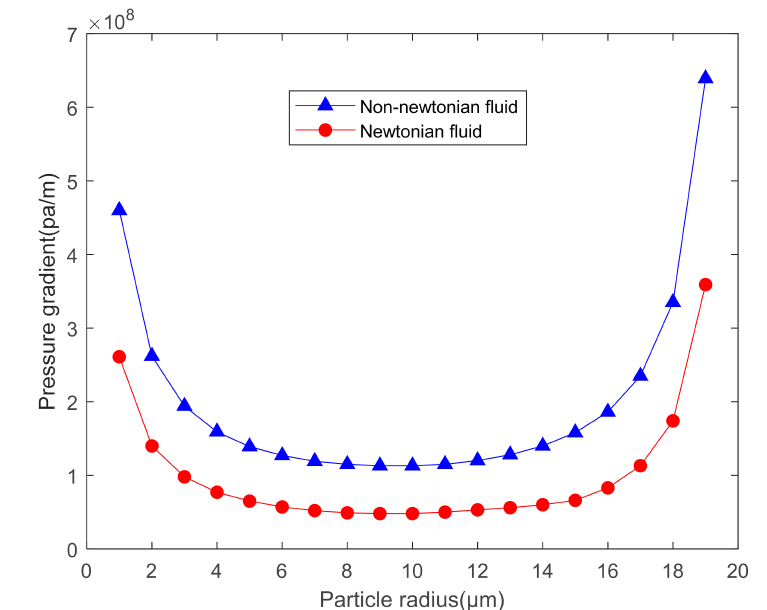
Figure 7. Pressure gradient curve of Newtonian fluid and non-Newtonian